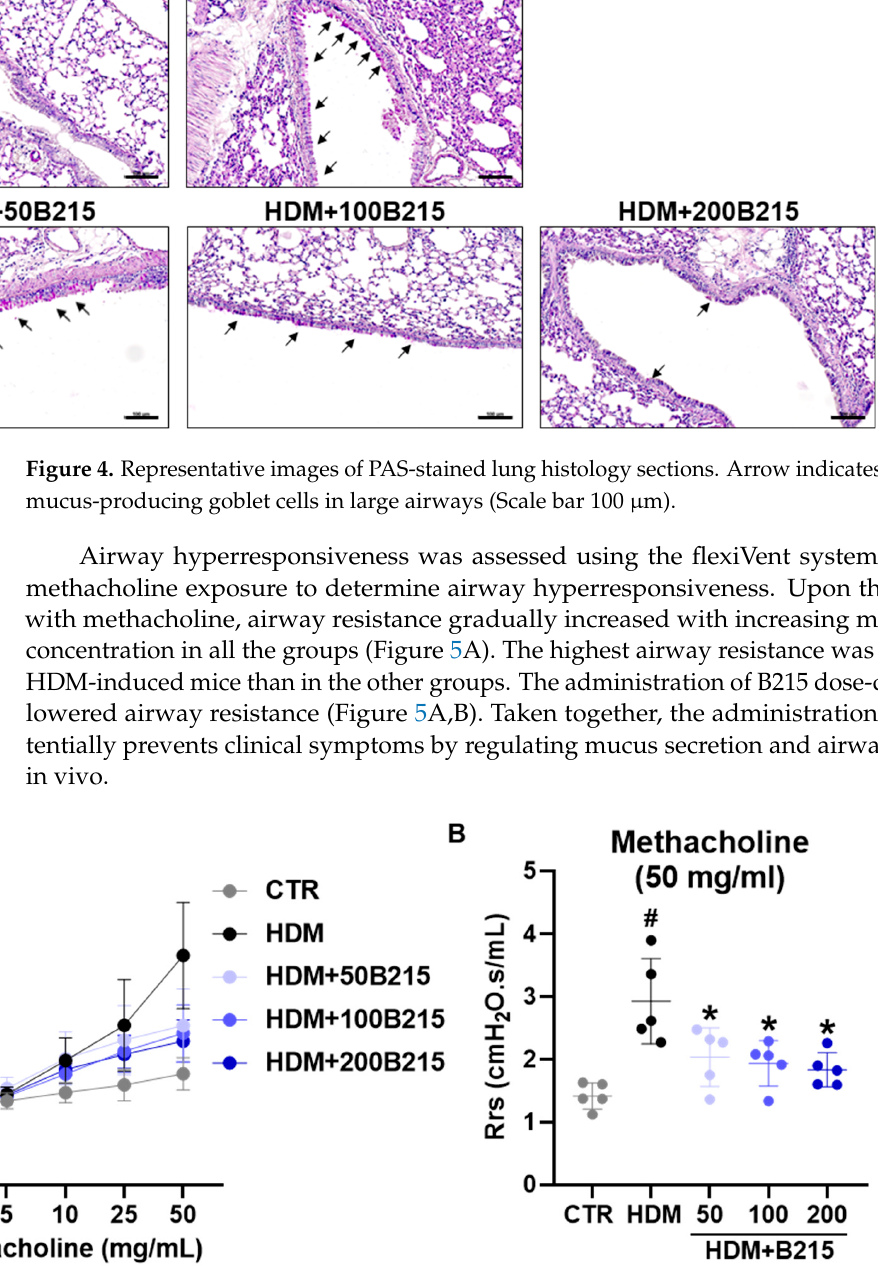
Figure 5. Airway hyperresponsiveness to methacholine in HDM-induced mouse model of lung inflammation. ( A ) Airway responsiveness to aerosolized methacholine (5 to 50 mg/mL) in different groups. ( B ) Airway responsiveness in different groups when challenged with 50 mg/mL methacholine. Gray, Control; Black, HDM; Light blue, HDM+50B215; Blue, HDM+100B215; Dark blue, HDM+200B215. Data are presented as mean ± SD (# and *, p < 0.05, compared to CTR and HDM, respectively).